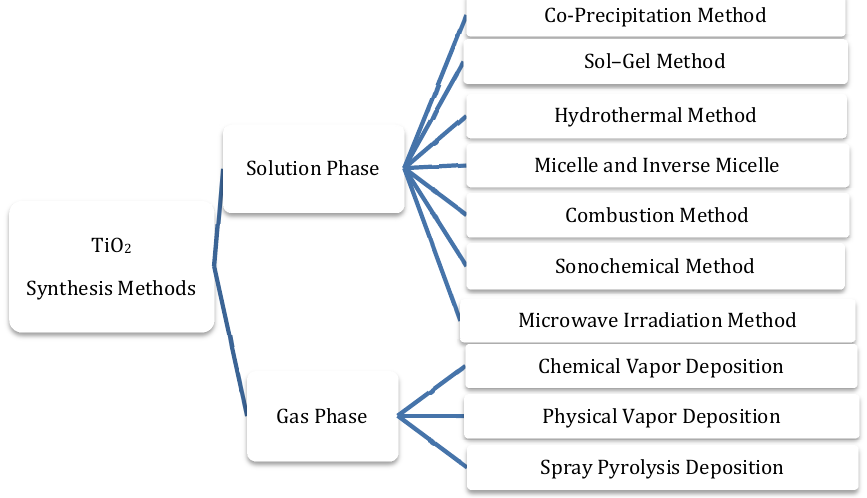
Figure 2. Synthesis methods for TiO 2 nanomaterials.